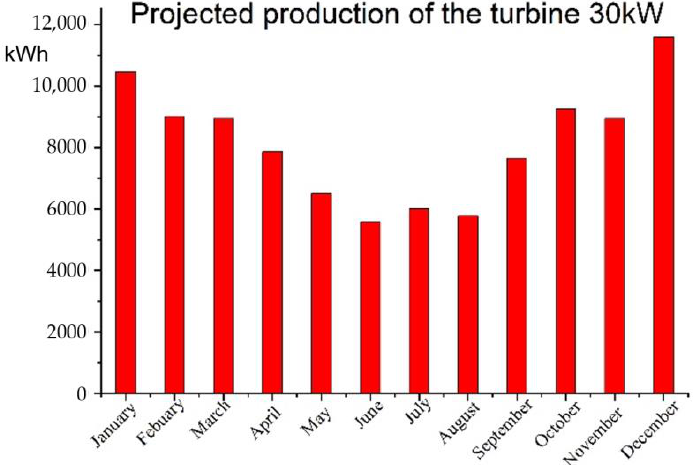
Figure 11. Energy generation forecasts broken down into individual months for the WT-30 turbine.